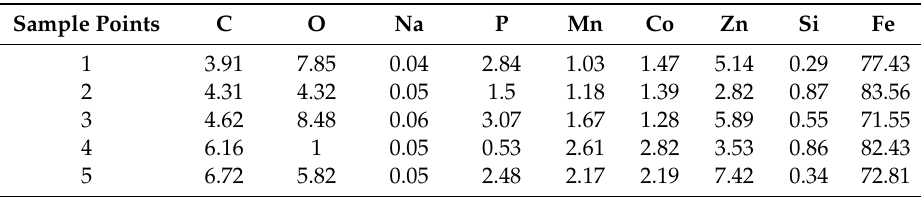
Table 1. Chemical compositions of steel wire (% in